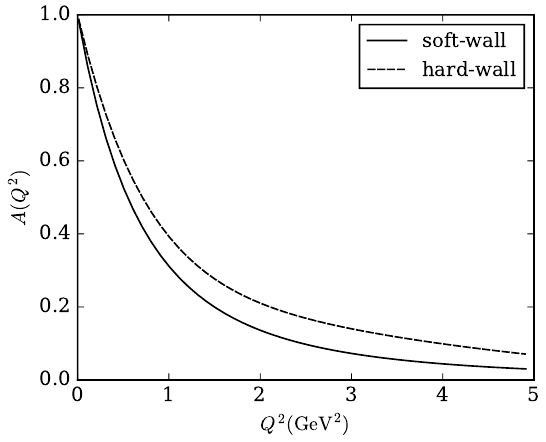
Figure 2 . The gravitational form factor of the proton from a bottom-up AdS/QCD model [39]. The solid and dashed lines are from the soft-wall and the hard-wall models,